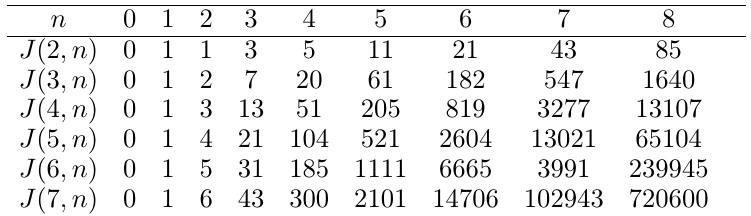
Table 1. The terms of { J ( k, n ) } for 2 ≤ k ≤ 7 and n ≤ 8